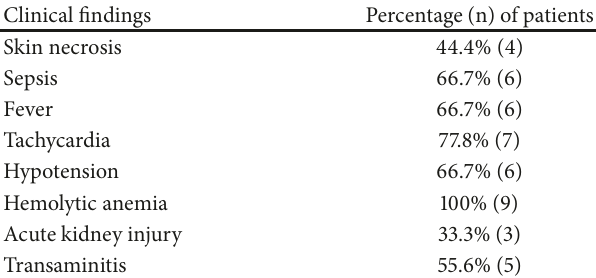
Table 2: Clinical findings and associated